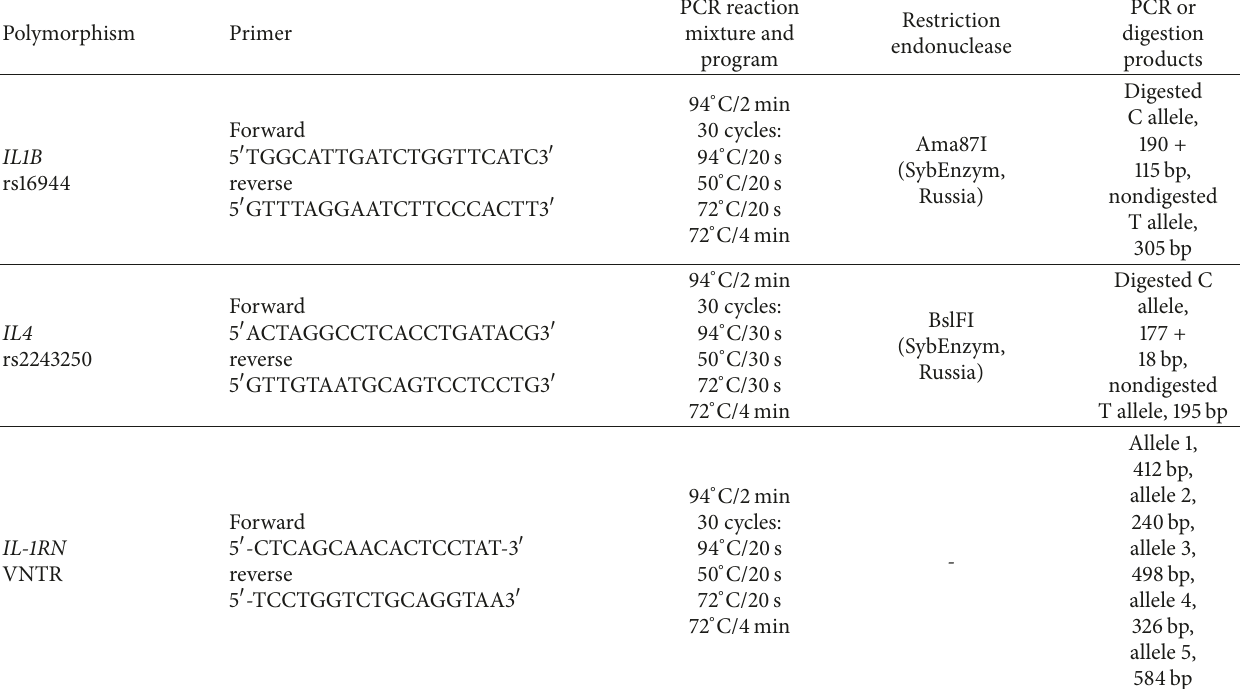
Table 2: Genotyping conditions for the IL1B rs16944, IL4 rs2243250, and IL-1RN VNTR polymorphisms.